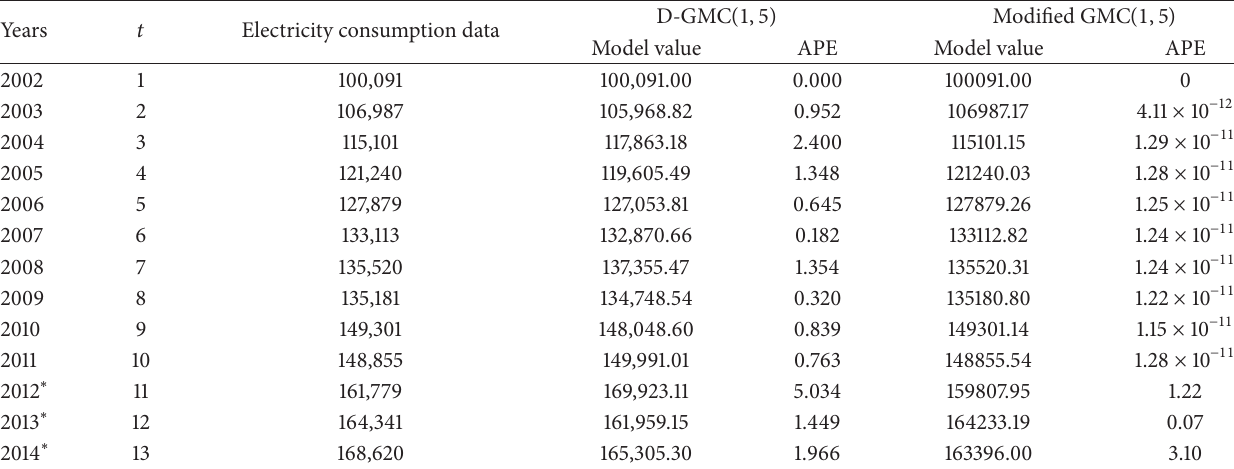
Table 4: Comparison of actual values, model values, and APE of D-GMC (1,5) and modified GMC (1,5) models.